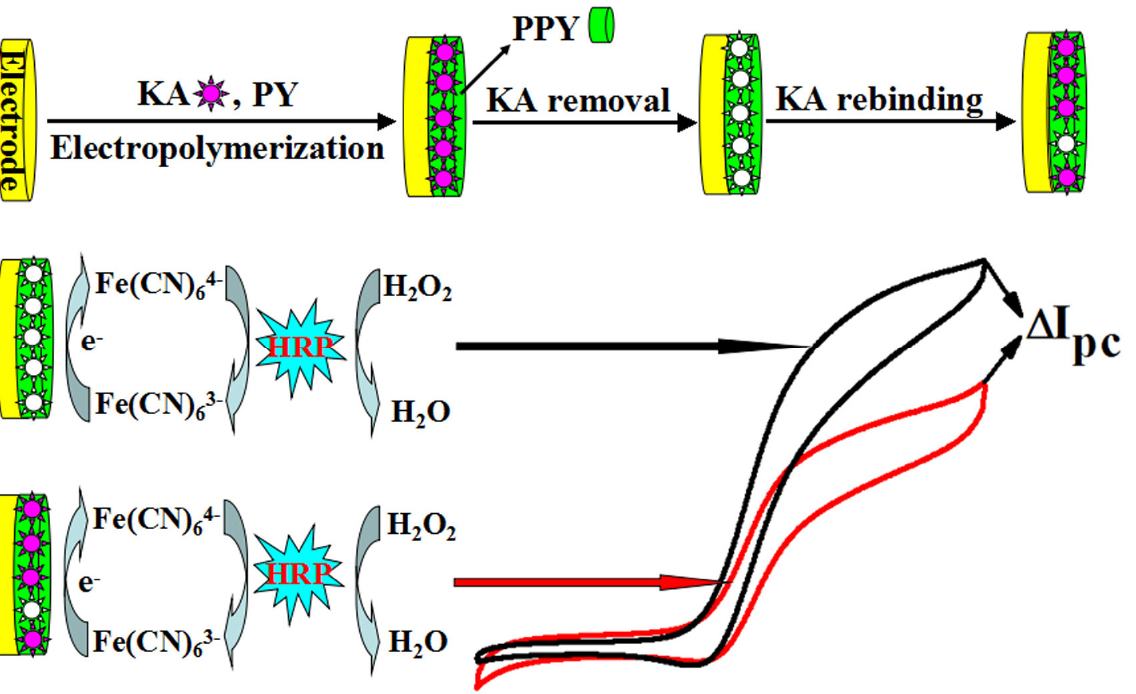
Figure 8. Fabrication protocol for amoxicillin MIP-based sensor using a combination of MWCNT, SWCNT, nanoparticles and ionic liquid, for sensitivity enhancement. Reprinted with permission from [168]. Copyright 2015